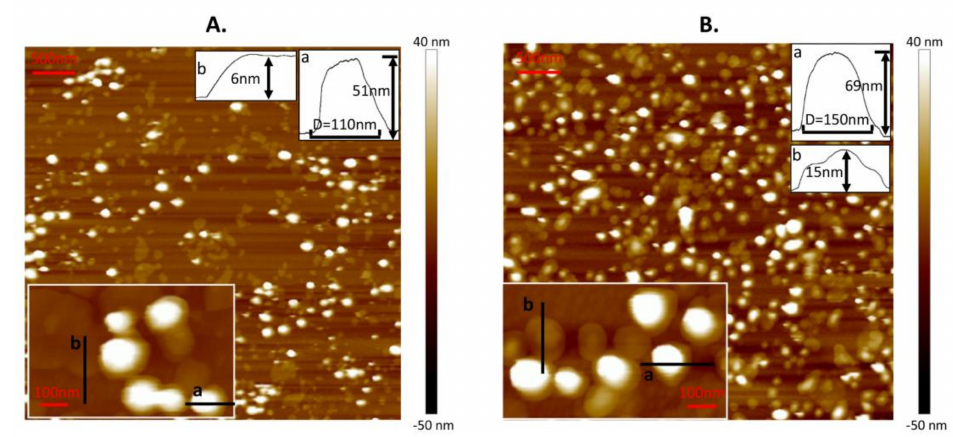
Figure 1. Atomic force microscopy (AFM) images of liposomes adsorbed onto Ti6Al4V at temperatures of ( A ) T 1 = 60 ◦ C and ( B ) T 2 = 25 ◦ C. Insets in the bottom left corner are magnified images. The lipid concentration is 0.1